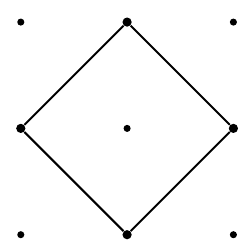
Figure 15. The toric diagram of C = Z 0